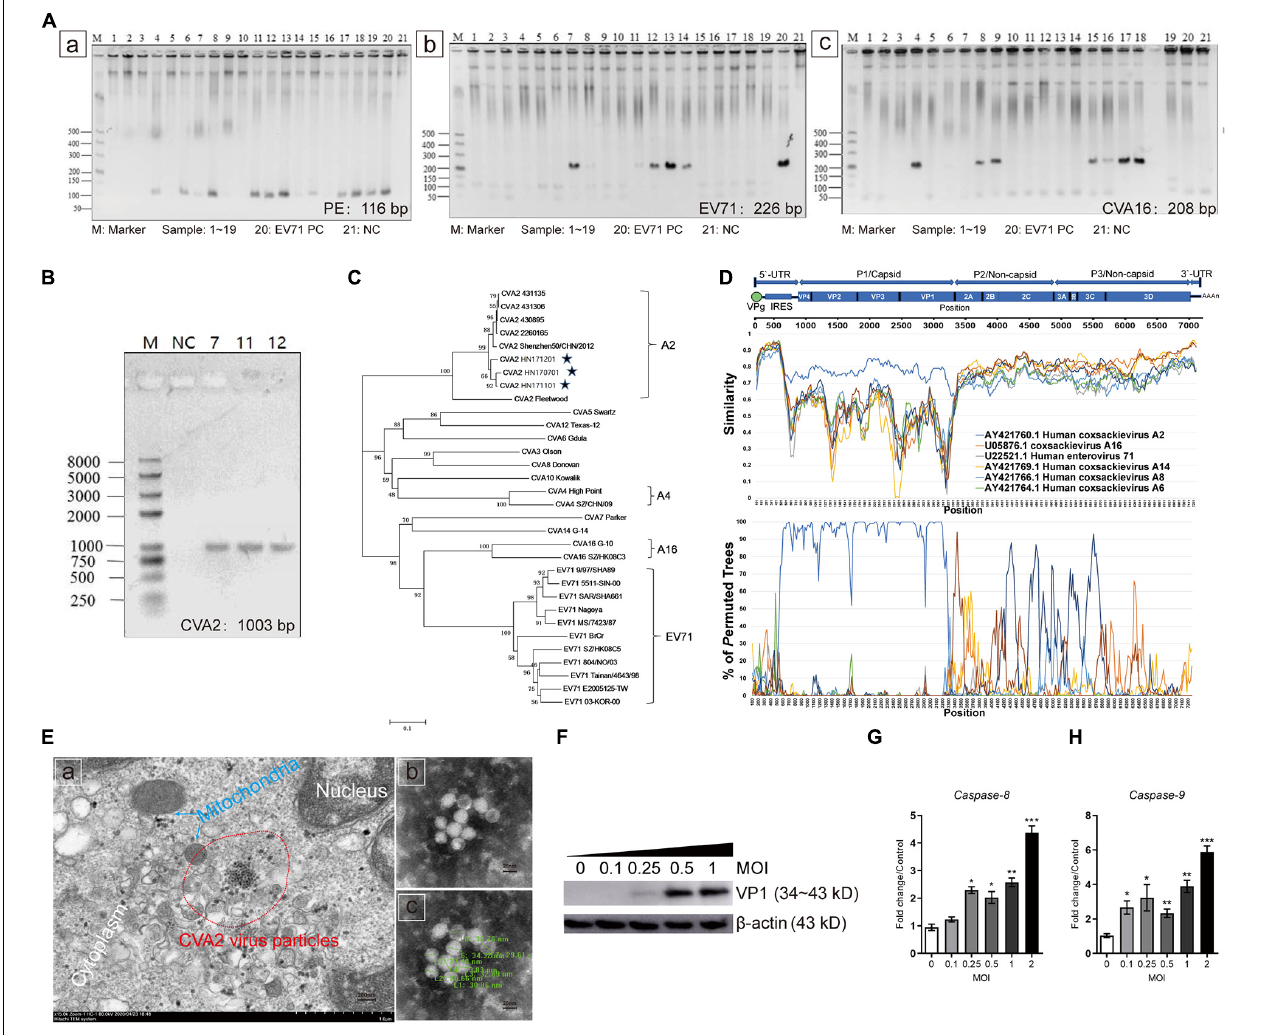
FIGURE 1 | Identification of CVA2 strains in clinical isolates from HFMD patients. (A) PCR analysis of 19 patient samples. a. samples 4, 6, 7, 8, 9, 11, 12, 13, 14, 15, 16, 17, 18, and 19 showed positive PE nucleic acid; b. Samples 7, 8, 11, 12, 13, and 14 were positive for EV71 nucleic acid; and c. Samples 4, 6, 8, 9, 15, 16, 17, and 18 were positive for CVA16 nucleic acid. (B) The PCR products (1,003 bp) of samples 7, 11, and 12. (C) A genetic evolutionary tree of samples 7, 11, and 12 VP1 (1,003 bp) by using the neighbor-joining method. (D) Recombination analysis of the full-length genome of HN202009 by using the Simplot. (E) Transmission electron micrograph of the infected Vero cells and inactivated CVA2 virions. a. Virus inclusion bodies in infected Vero cells; b and c. Spherical particles of the CVA2 virions with a diameter of 26 ∼ 35 nm. (F) The relative expression of VP1; and (G,H) . The expression of caspase-8 and caspase-9 RNA in the infected cells with increased doses of CVA2. Positive control, PC; negative control, NC. * P < 0.05; ** P < 0.01; *** P <